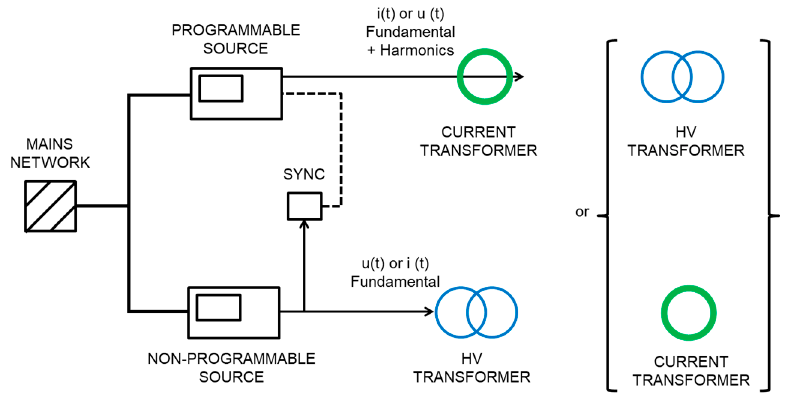
Figure 6. Low voltage circuits used for generating both voltage u(t) and current i(t) waveforms